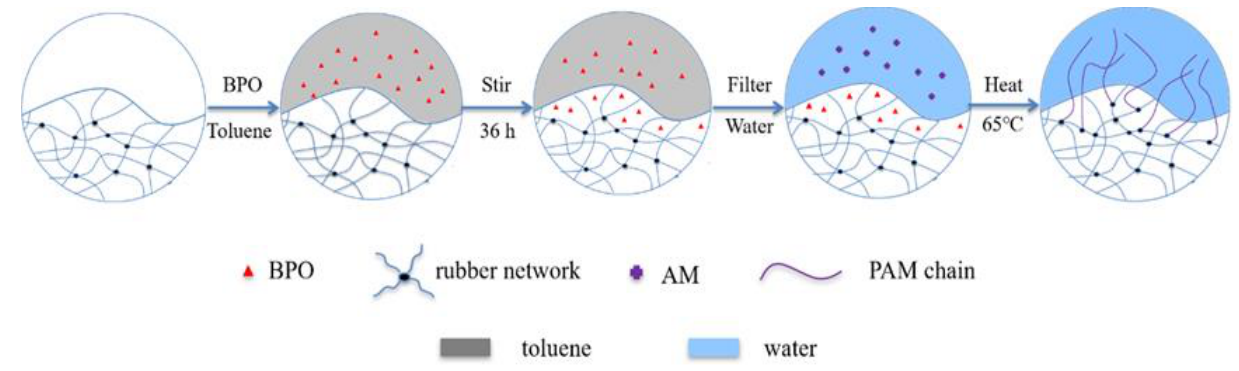
Figure 1. Schematic diagram of the HRP preparation.